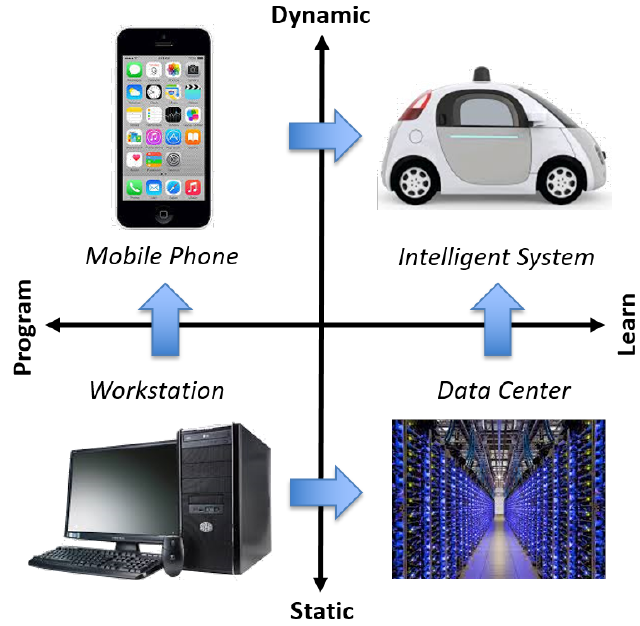
Figure 1. The technology landscape is divided into four application domains separated by two features: (1) programmed vs learned (horizontal axis) and (2) dynamic or static in time (vertical axis). A few decades ago applications were largely confined to the lower left corner as illustrated by the